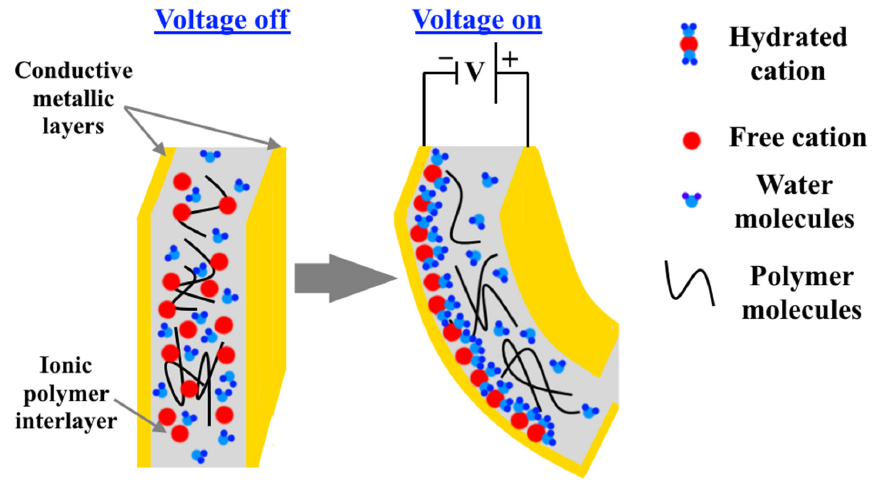
Figure 13. Work principle for the ionic EAPs.